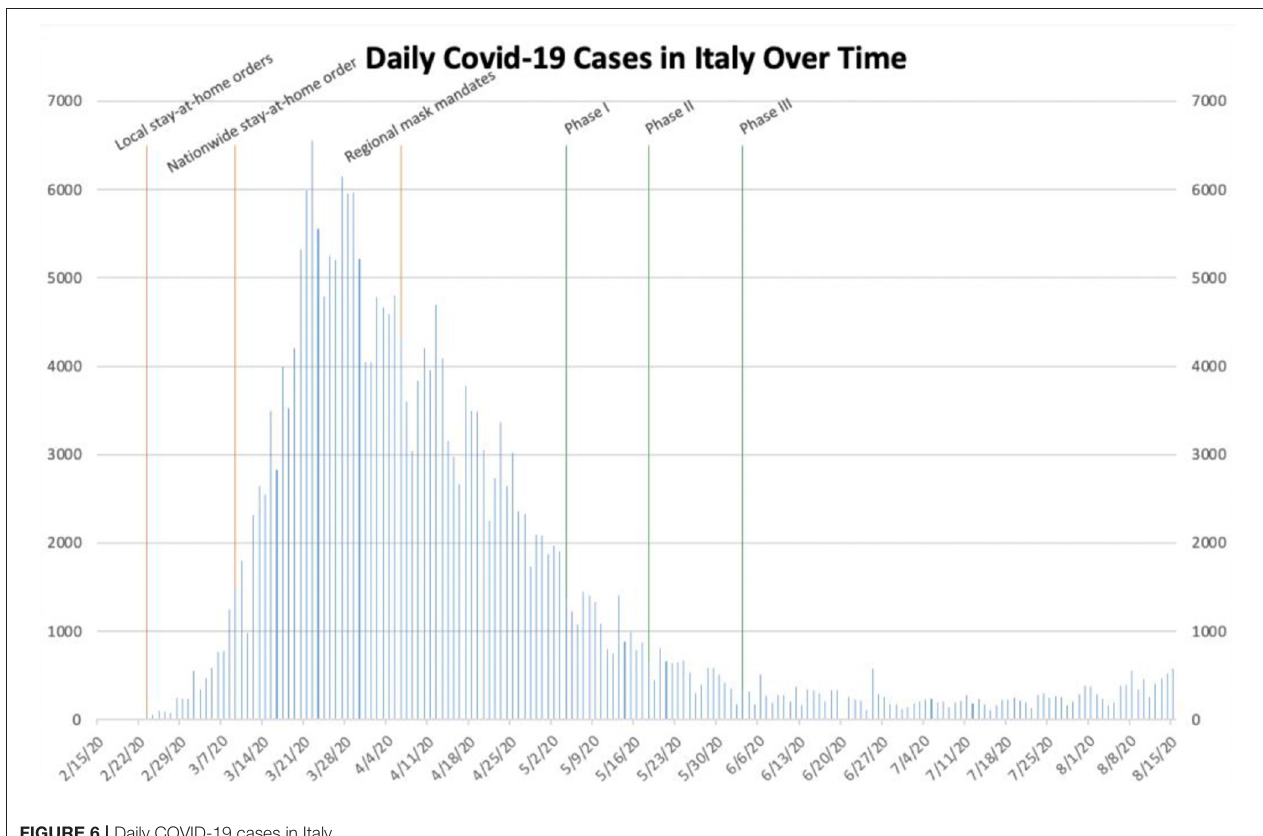
FIGURE 6 | Daily COVID-19 cases in